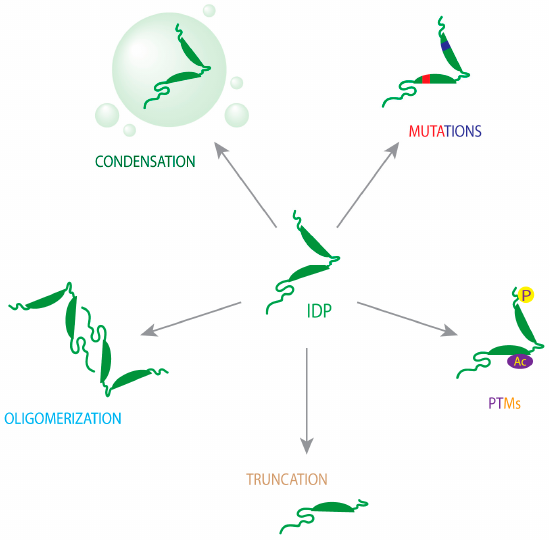
Figure 2. Molecular underpinnings of ND-linked IDP misfolding and aggregation.